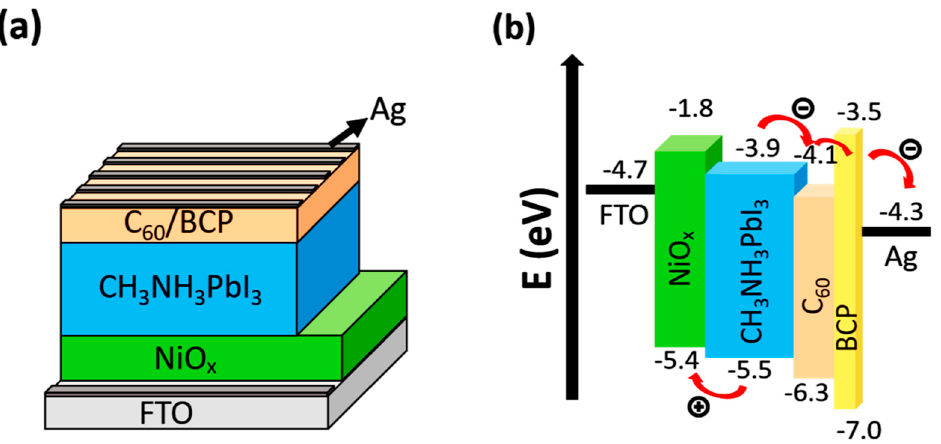
Figure 1. The perovskite solar cell device: ( a ) Inverted (p-i-n structure) configuration; ( b ) the energy level diagram of the working principle.